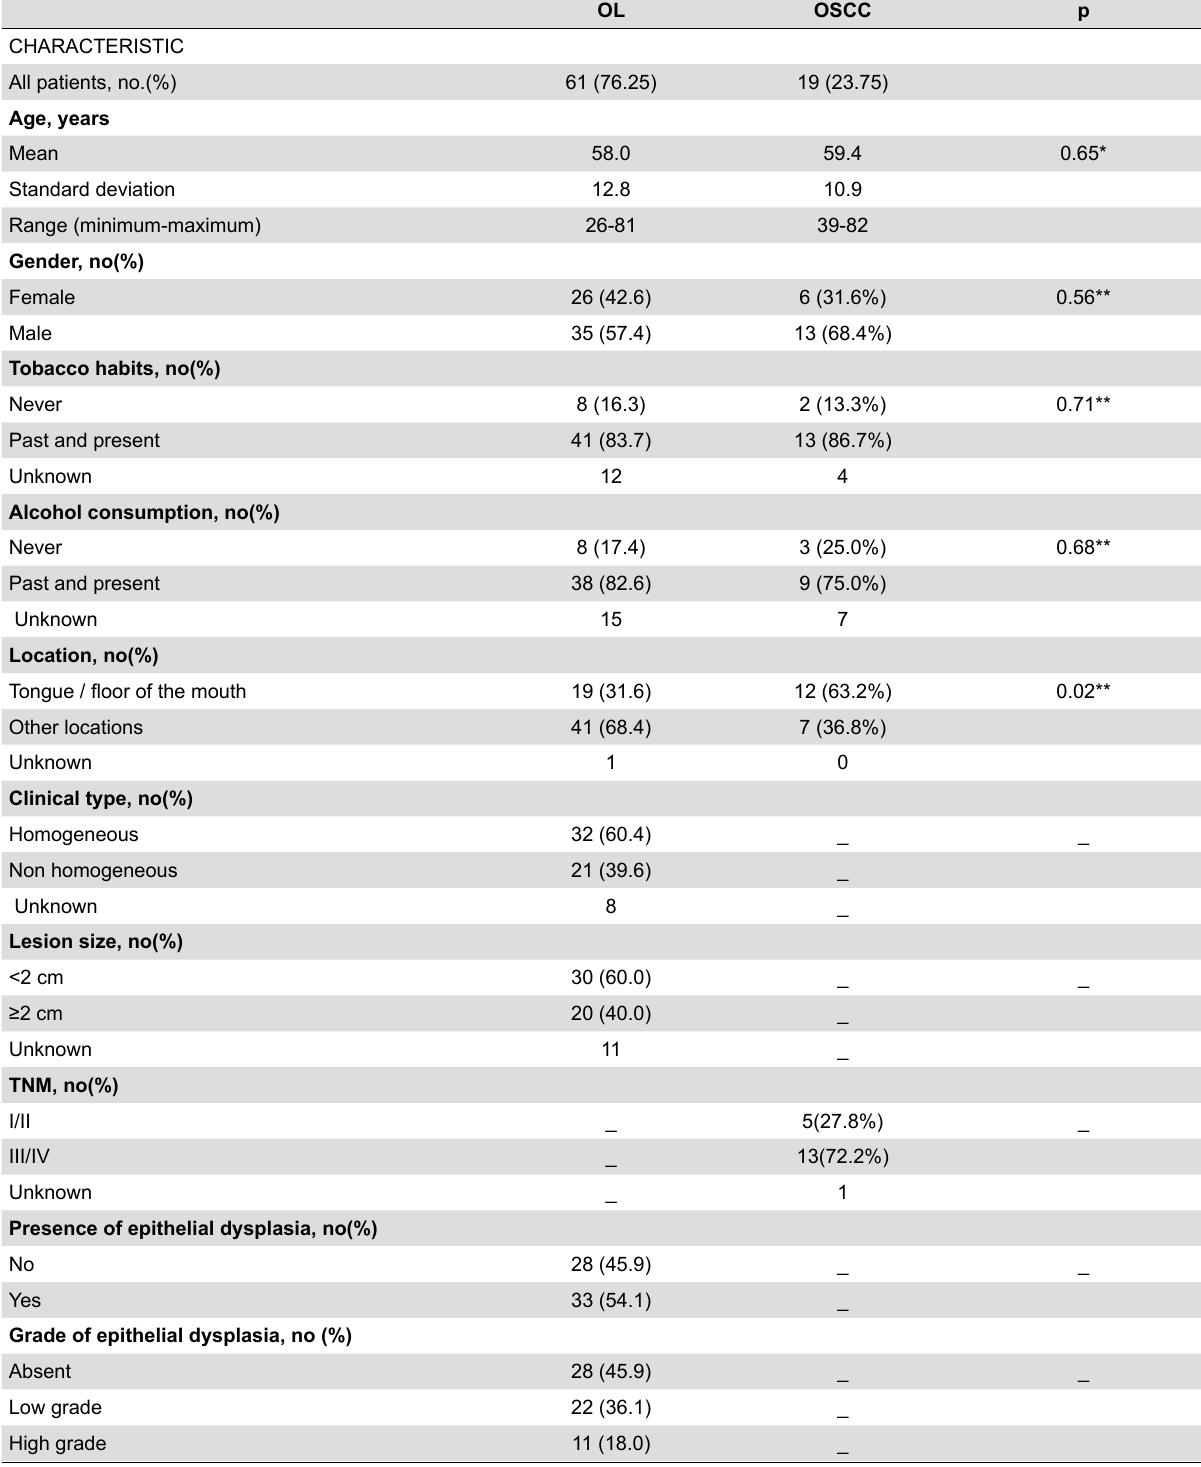
BMI-1 expression increases in oral leukoplakias and correlates with cell Table 1- Demographic and clinical characteristics of the OL and OSCC patient OL